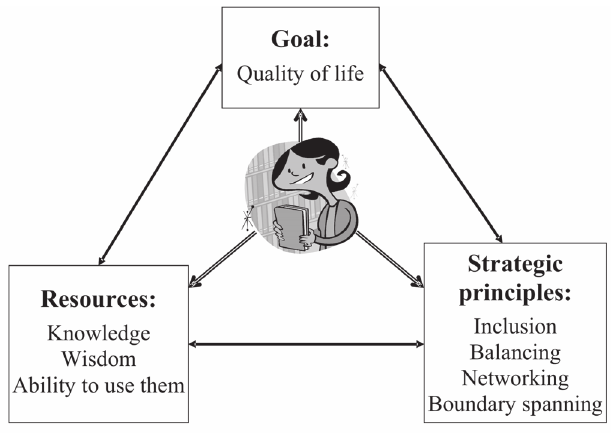
Fig 8. Knowledge-based human-centred growth